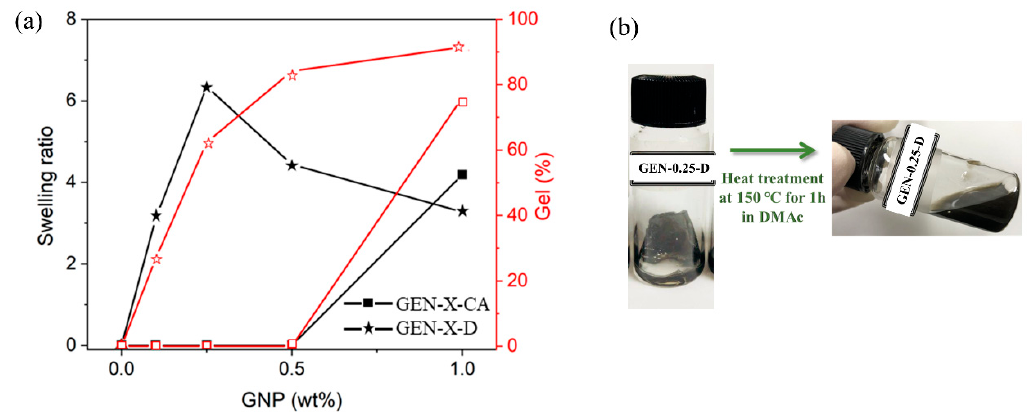
Figure 7. ( a ) Swelling test results for composites of the CA and D systems, ( b ) Digital image of GEN-0.25-D after heat treatment in DMAc.